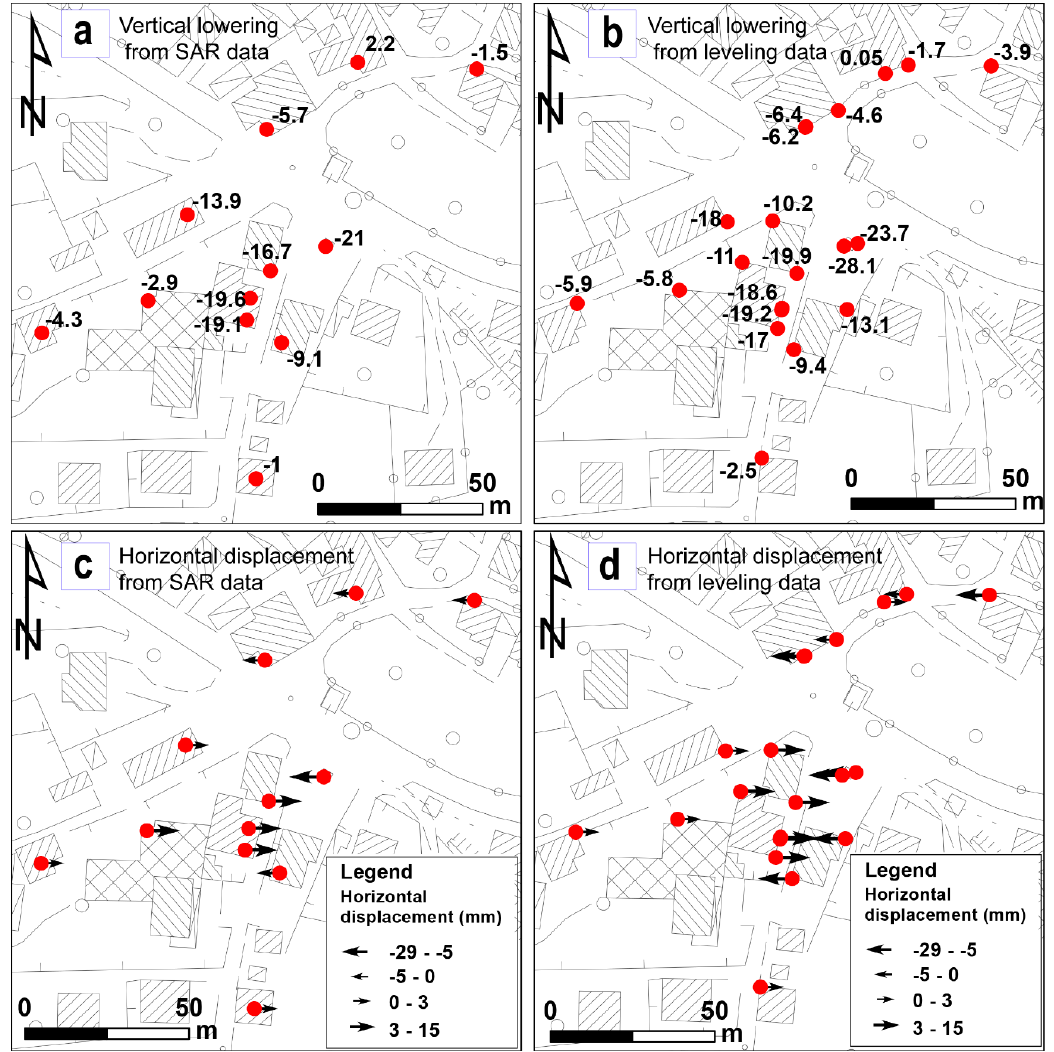
Figure 12. ( a ) Vertical lowering and ( c ) E-W horizontal displacement from interferometric data; ( b ) vertical lowering and ( d ) E-W horizontal displacement from precise leveling. All data are related to the period 2012–2015 and are in mm.